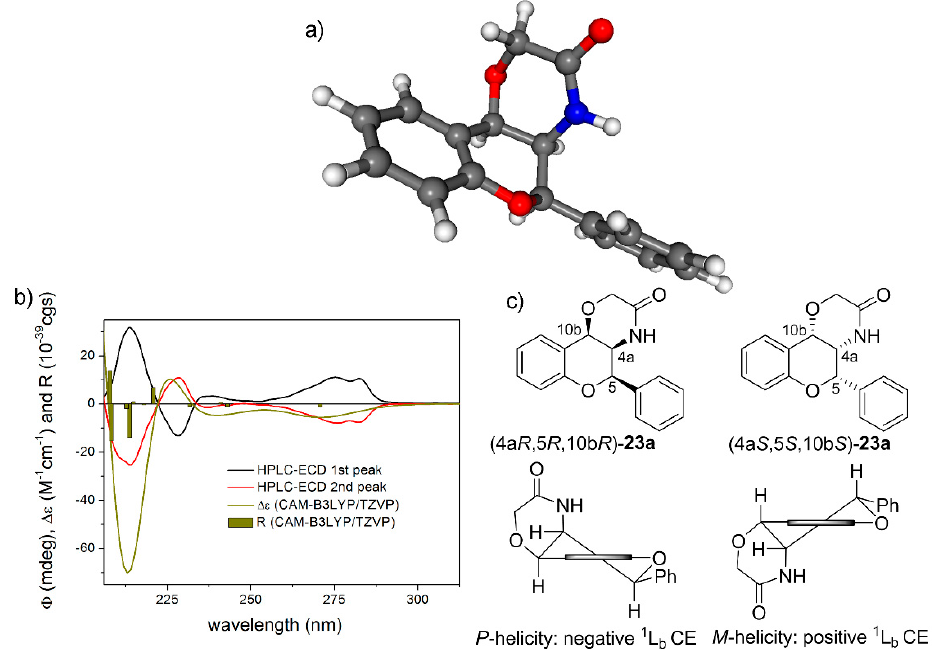
Figure 8. ( a ) Single low-energy CAM-B3LYP / TZVP PCM / CHCl 3 conformer of (4a R ,5 R ,10b R )- 23a containing a flavan chromophore with P -helicity. ( b ) HPLC-ECD spectra of the first- (black line) and the second-eluting (red line) enantiomers of rac - 23a compared with the CAM-B3LYP / TZVP PCM / CHCl 3 // CAM-B3LYP / TZVP PCM / CHCl 3 spectrum of (4a R ,5 R ,10b R )- 23a (olive line). The bars represent rotational strength values for the single low-energy solution conformer. ( c ) Structure and helicity of the (4a R ,5 R ,10b R )- 23a and (4a S ,5 S ,10b S )- 23a . Horizontal thick line represents the plane of the condensed benzene ring.